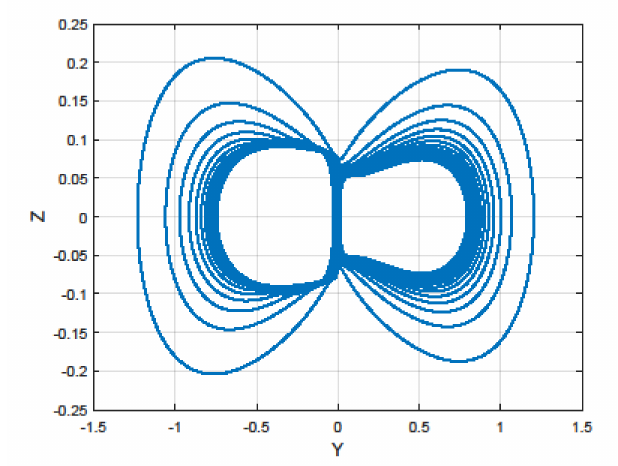
Figure 12. The 2-D signal plot of the discrete-time chaotic system (9) using Forward Euler finite- difference scheme in the ( y , z ) plane.